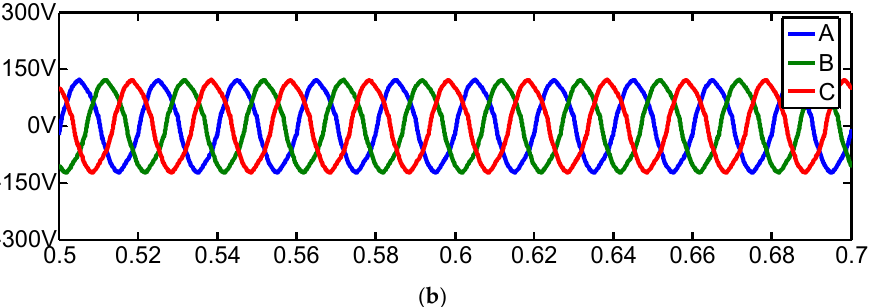
Figure 27. Output voltages for different MMC topologies with trapezoidal modulation under λ = 1. ( a ) Output voltage under a traditional MMC. ( b ) Output voltage under the proposed hybrid MMC.